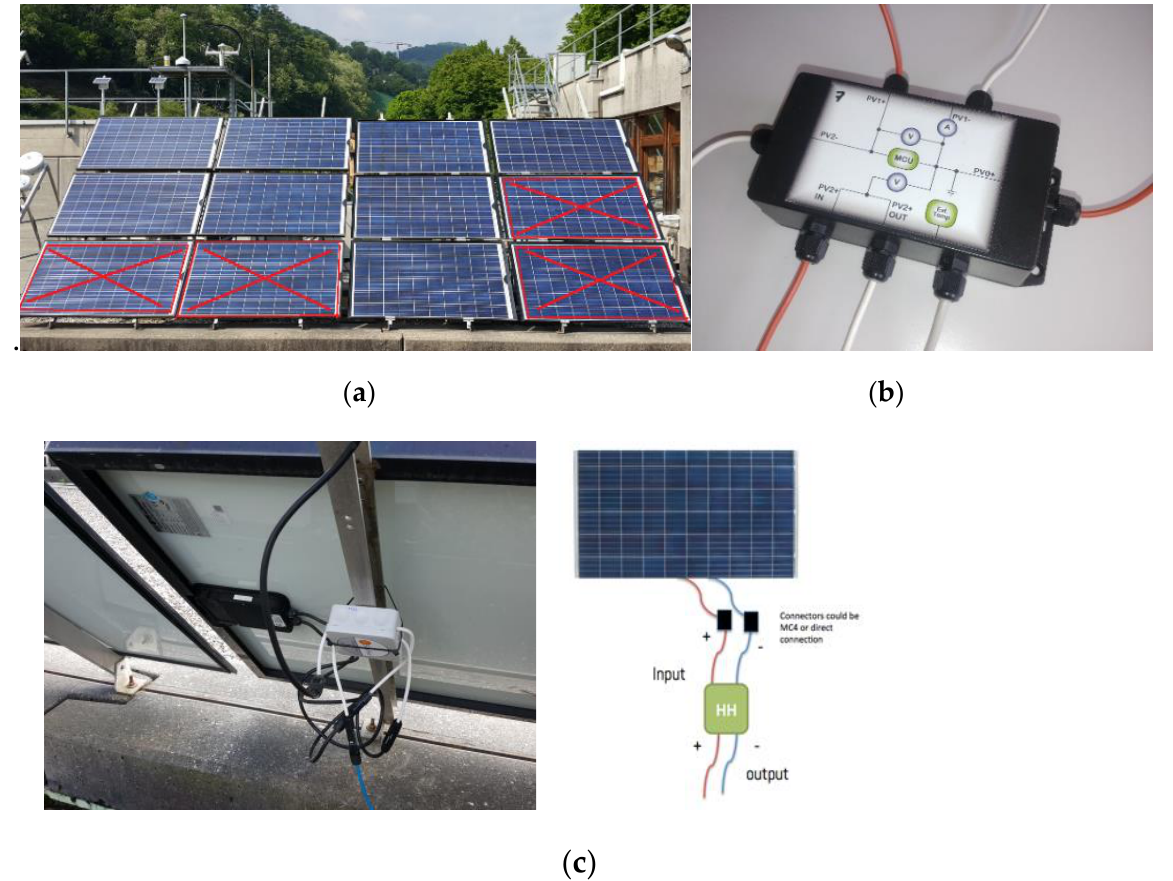
Figure 4. Setup of the experimental PV system: ( a ) PV installation, ( b ) HH device in the experimental setup, and ( c ) connecting HH device to the PV module. Table 5. PV module fault simulation and emulation.